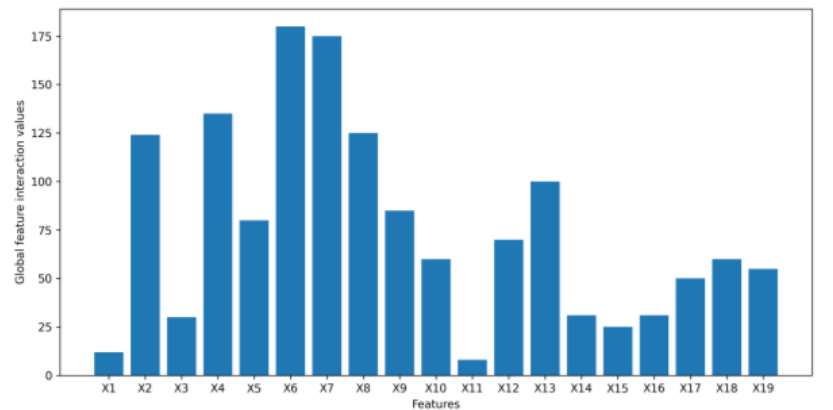
Figure 18. Global feature interaction values for dataset 2.